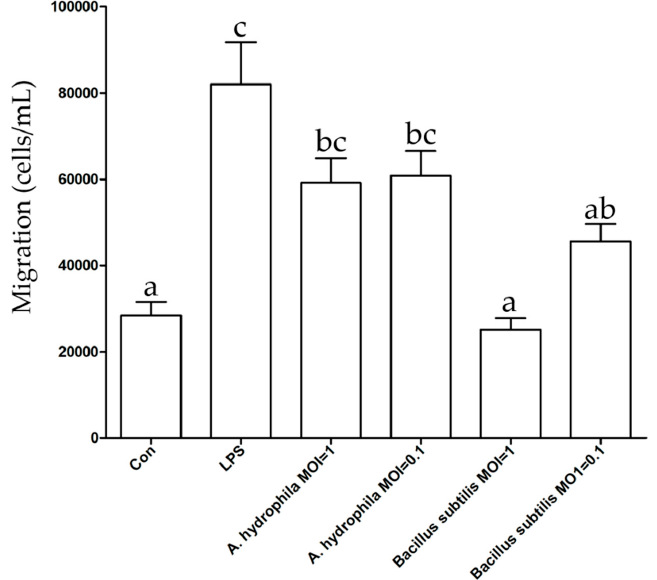
Figure 3. Migration analysis of gDCs towards different treatments. Pairwise group comparisons were conducted using analysis of variance (ANOVA) with the Tukey post-test. p < 0.05 indicated statistically significant differences between groups. Data are expressed as mean ± standard deviation (SD) ( n = 3). Shared letters above bars indicate the groups were not statistically different from one another ( p > 0.05), while differing letters indicate significantly different mean values ( p <